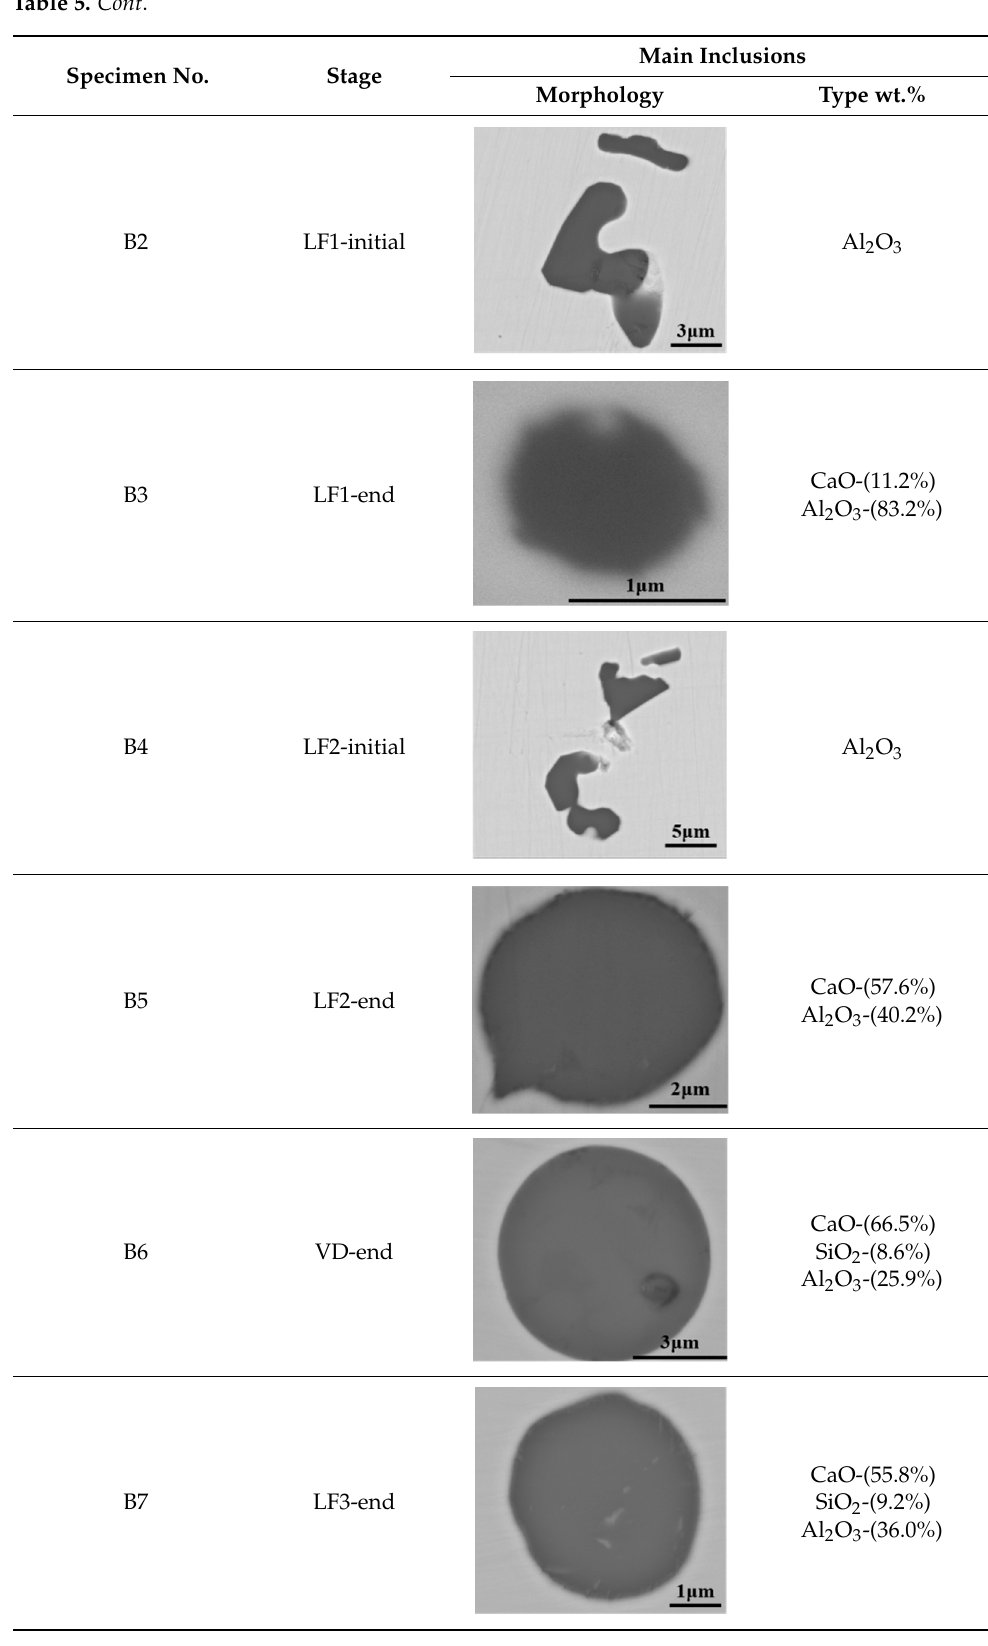
Figure 9. Composition and size distribution of large-size inclusions during the optimized metallur- gical process in CaO-SiO 2 -Al 2 O 3 ternary phase diagram at 1873 K. The type and the average size of all type inclusions at each stage was shown in Figure 10. SiO 2 -MnO-Al 2 O 3 inclusions were found after the LF2-initial stage, which could be en- trapped from the slag during the avoiding slag process. Owing to the optimized control of aluminum content, Al 2 O 3 inclusions dominated in inclusions before LF-2 refining,